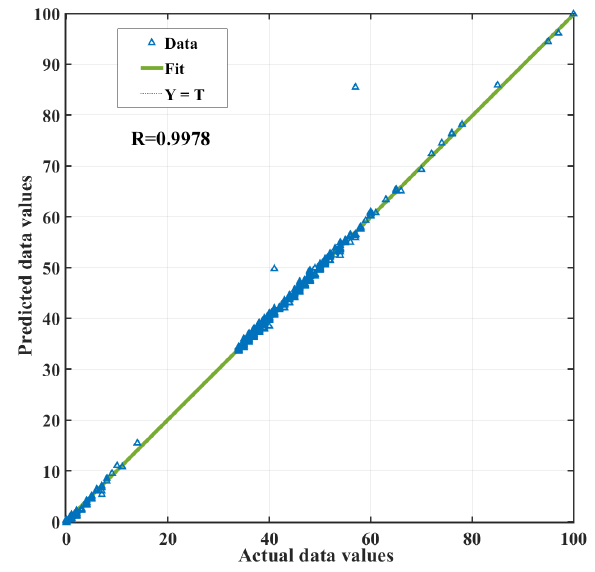
Figure 9. Performance of model on Testing data set based on R 2 .